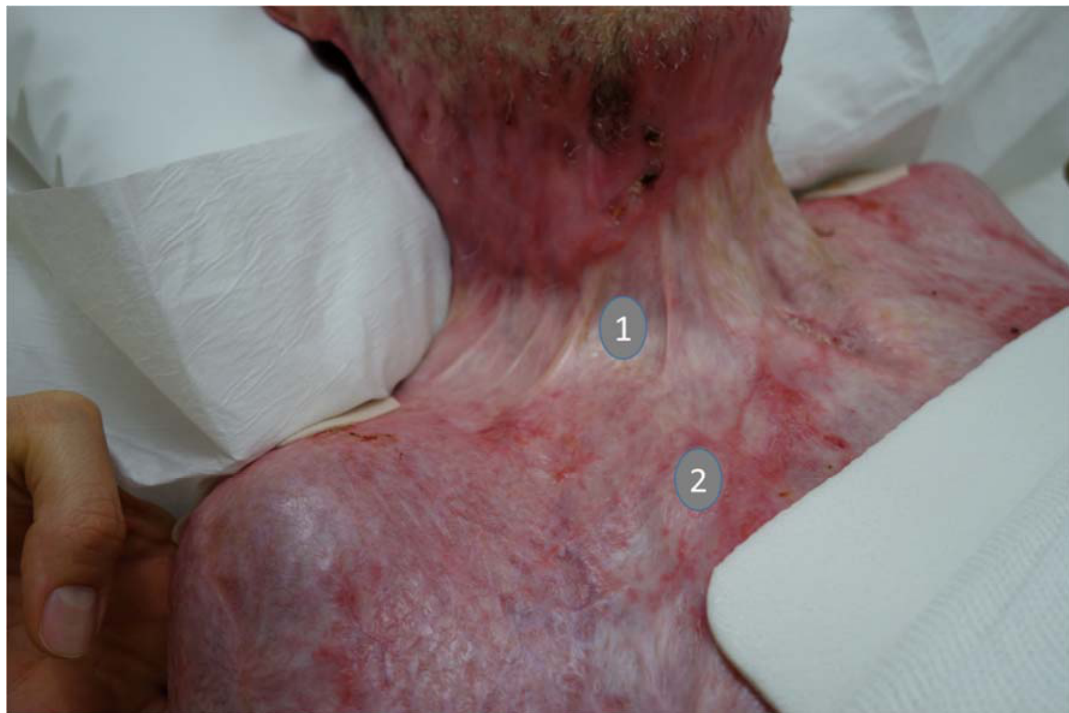
Figure 2. Typical course of scar contractures in the neck area. Legend: (1). Concavely scarred strand in the area of the neck. The scarred strands are mechanically stable and transmit mechanical forces during movements without damage. (2). Scar areas that are still in the inflammatory or proliferation phase (red scar areas) react to mechanical forces that are too strong with a tension equalization